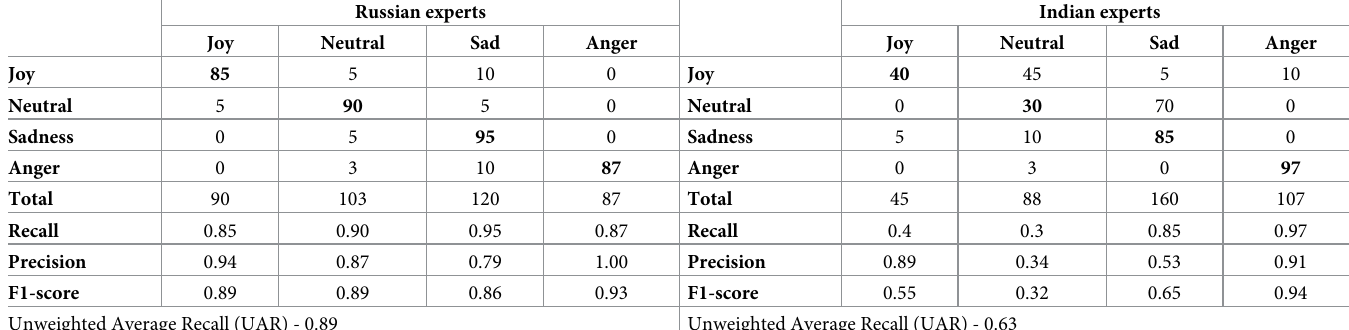
Table 6. Confusion matrix for emotion recognition in the emotional words of Russian children by Russian and Indian